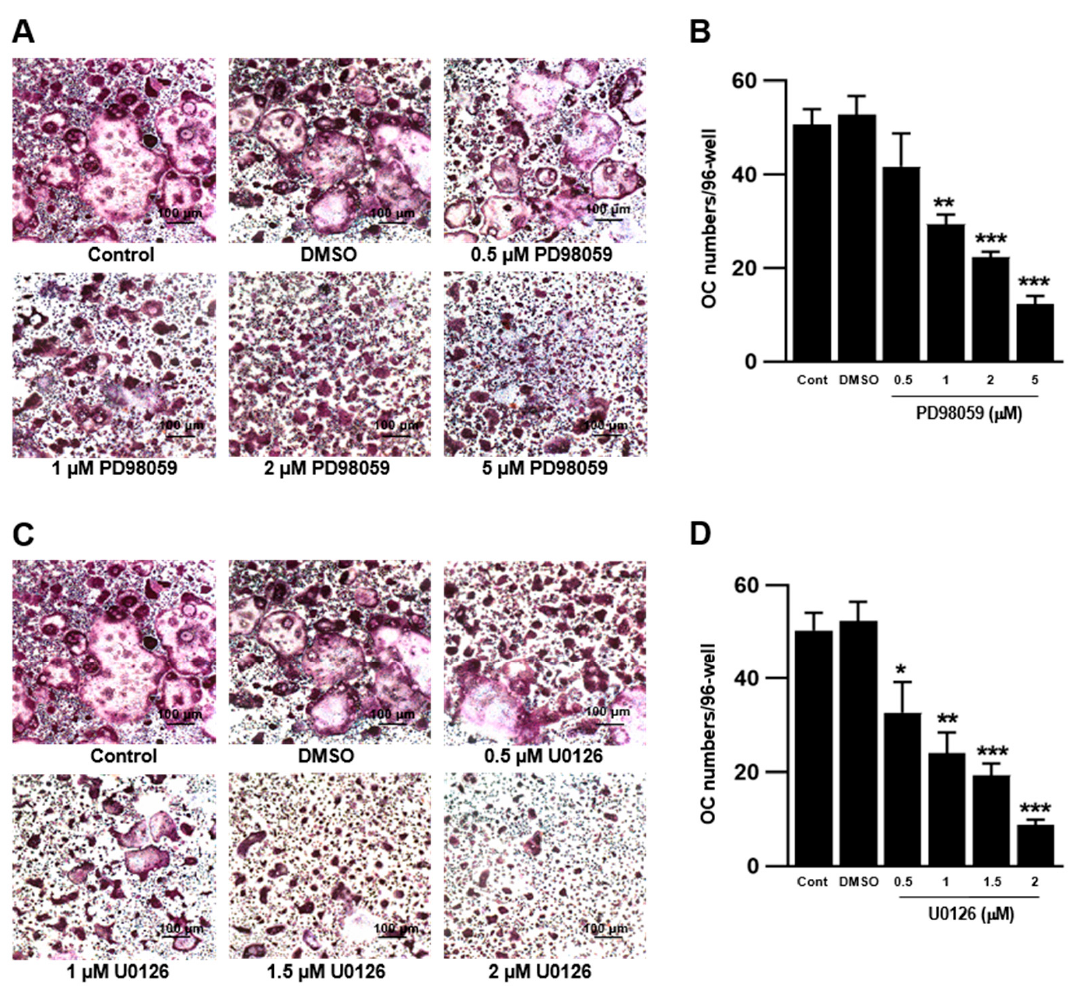
Figure 2. Inhibition of ERK decreased OC differentiation in bone marrow monocytes (BMMs). Cells were cultured with 30 ng/mL macrophage colony-stimulating factor (M-CSF) for 3 days and then treated with PD98059 and U0126 in the presence of 30 ng/mL M-CSF and 50 ng/mL RANKL for 4 days. ( A , B ) Effect of PD98059 on OC differentiation from BMMs (n = 3 independent experiments, each performed in triplicate). ( C , D ) Effect of U0126 on OC differentiation from BMMs (n = 3 inde- pendent experiments, each performed in triplicate). Each result represents the mean ± SD. * p < 0.05, ** p < 0.01, and *** p < 0.001 vs. DMSO.